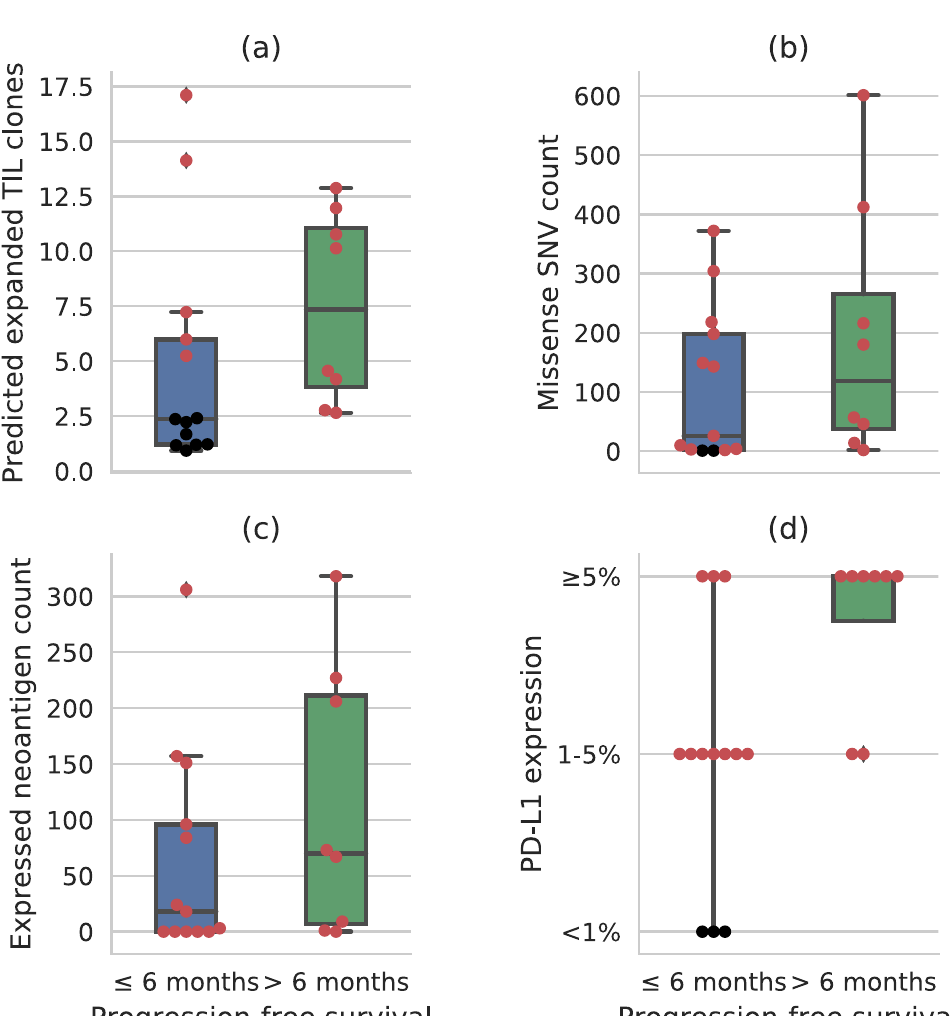
Fig 3. Distributions of biomarker values in patients with and without durable clinical benefit (DCB, defined as � 6 months of progression-free survival): (A) predicted number of expanded TIL clones; (B) missense SNV count; (C) expressed neoantigen count; and, (D) percentage of tumor infiltrating immune cells found to be PD-L1-positive. When each biomarker alone is used for triage, the patients highlighted in red must be treated to ensure all DCB patients are